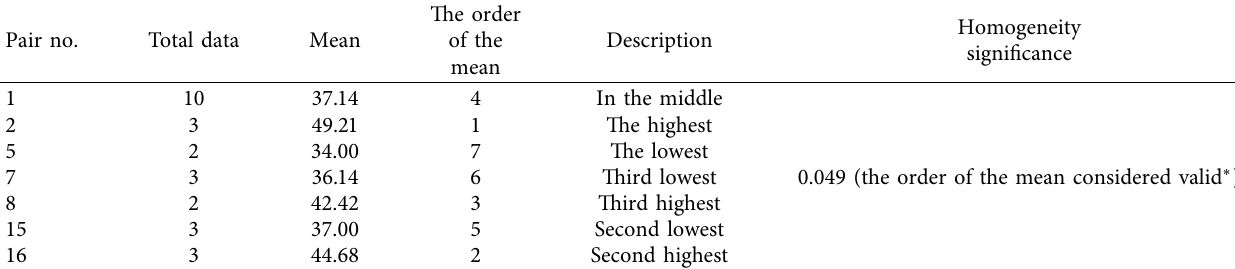
Table 8: ANOVA test results of acceptance level data based on grouping of total population and GDP. Pair